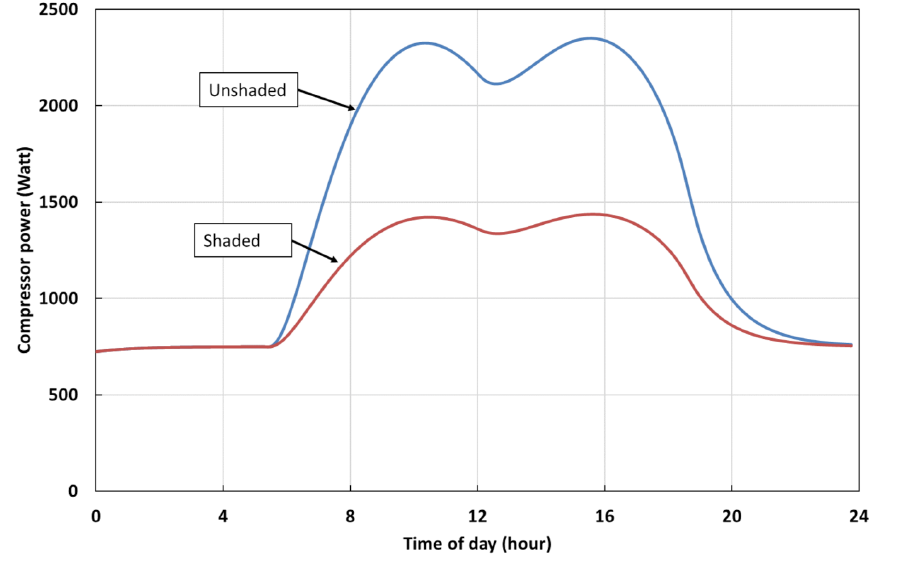
Figure 11. Compressor power required to maintain a constant 5 ◦ C temperature inside the cold storage unit. Shaded by the solar array vs. unshaded container. Mounting the PV array on top of the container can significantly shade the container, resulting in a reduction in the steel wall temperature of the cold storage